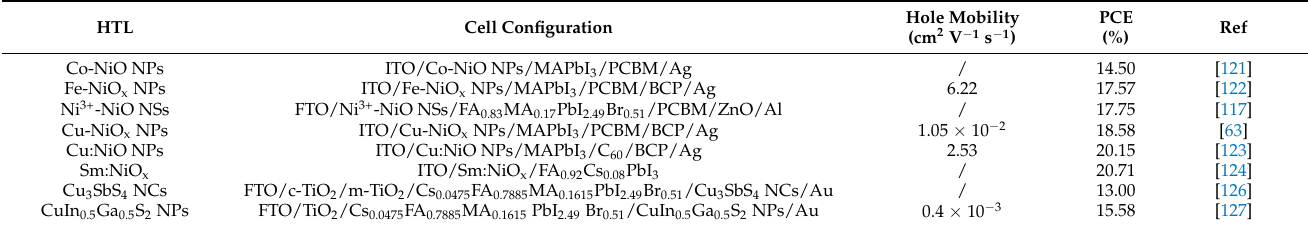
Table 1. Performance comparison of PSCs with doped NPs-based inorganic HTLs.